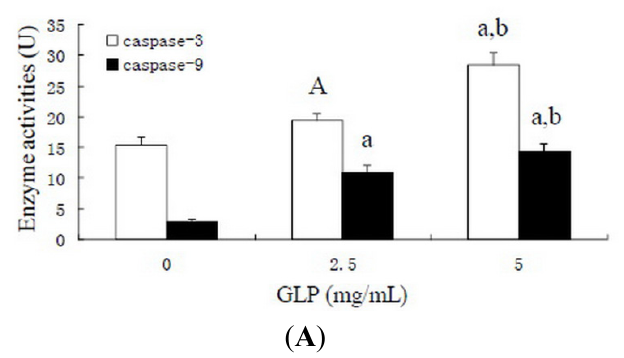
Figure 7. GLP induces cell apoptosis via caspase-dependent mitochondrial